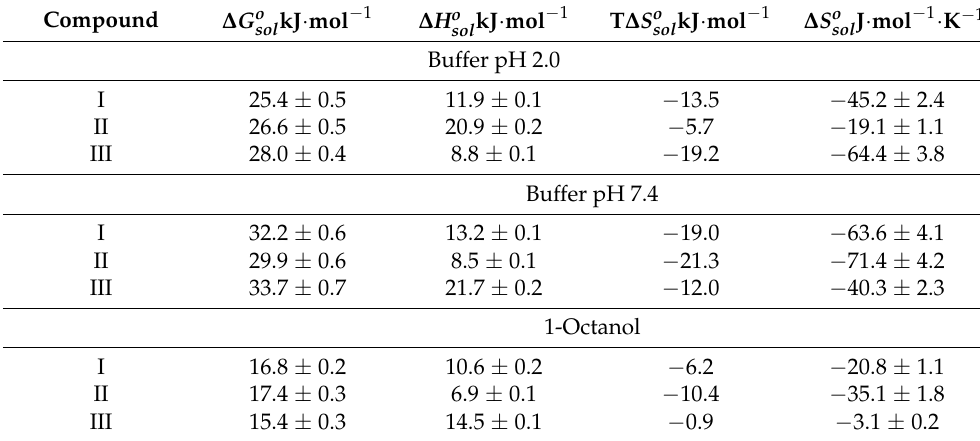
Table S5. The calculated apparent thermodynamic solubility functions of dissolution (Gibbs energy, enthalpy, and entropy) at standard temperature 298.15 K for hybrid compounds were collected in Table 4. Table 4. Apparent thermodynamic solubility functions of compounds studied in buffer solutions (pH 2.0 and 7.4) and 1-octanol at T hm = 302.98 K and pressure p = 0.1